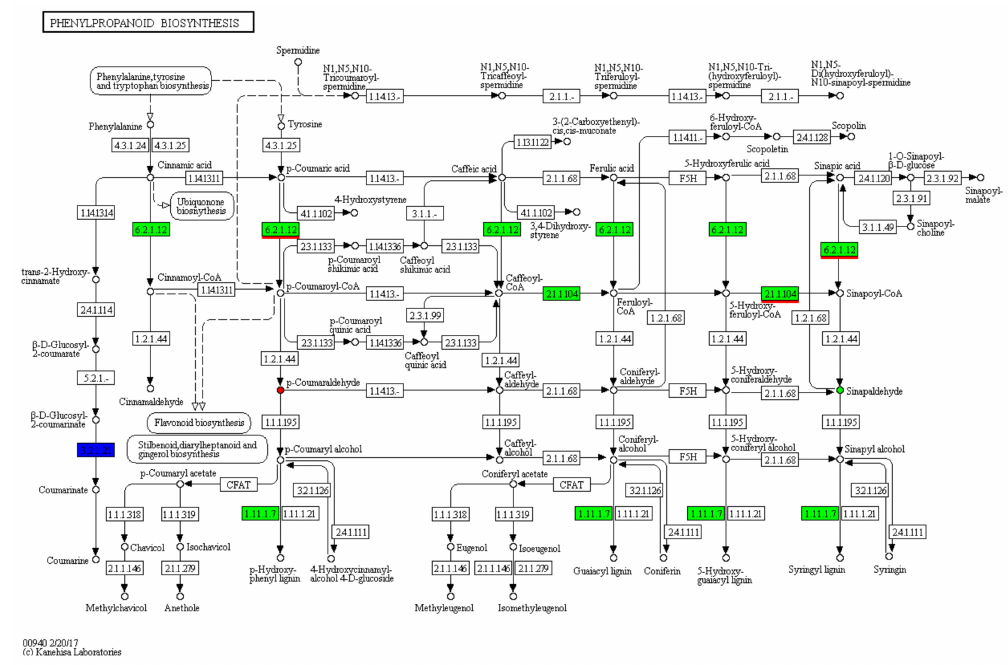
Figure 4. DEG-annotated phenylpropanoid biosynthesis. Red circle: up-regulated DAM. Green circle: down-regulated DAM. White circle: unchanged metabolite. Arrow: metabolic reaction direction. The number in every box composed of 4 numbers: EC number. EC numbers in the boxes with green background: enzymes included in R. glutinosa. EC numbers in the boxes with white background: enzymes not included in R. glutinosa. EC numbers in the blue box: enzymes included, up- and down-regulated in R. glutinosa. 4-coumarate-CoA ligase (EC 6.2.1.12), caffeoyl-CoA O-methyltransferase (EC 2.1.1.104), and peroxidase (EC1.11.1.7) in green boxes. beta-glucosidase (EC3.2.1.21) in the blue box. The numbers underlined in red: the same enzymes as shown in Figure